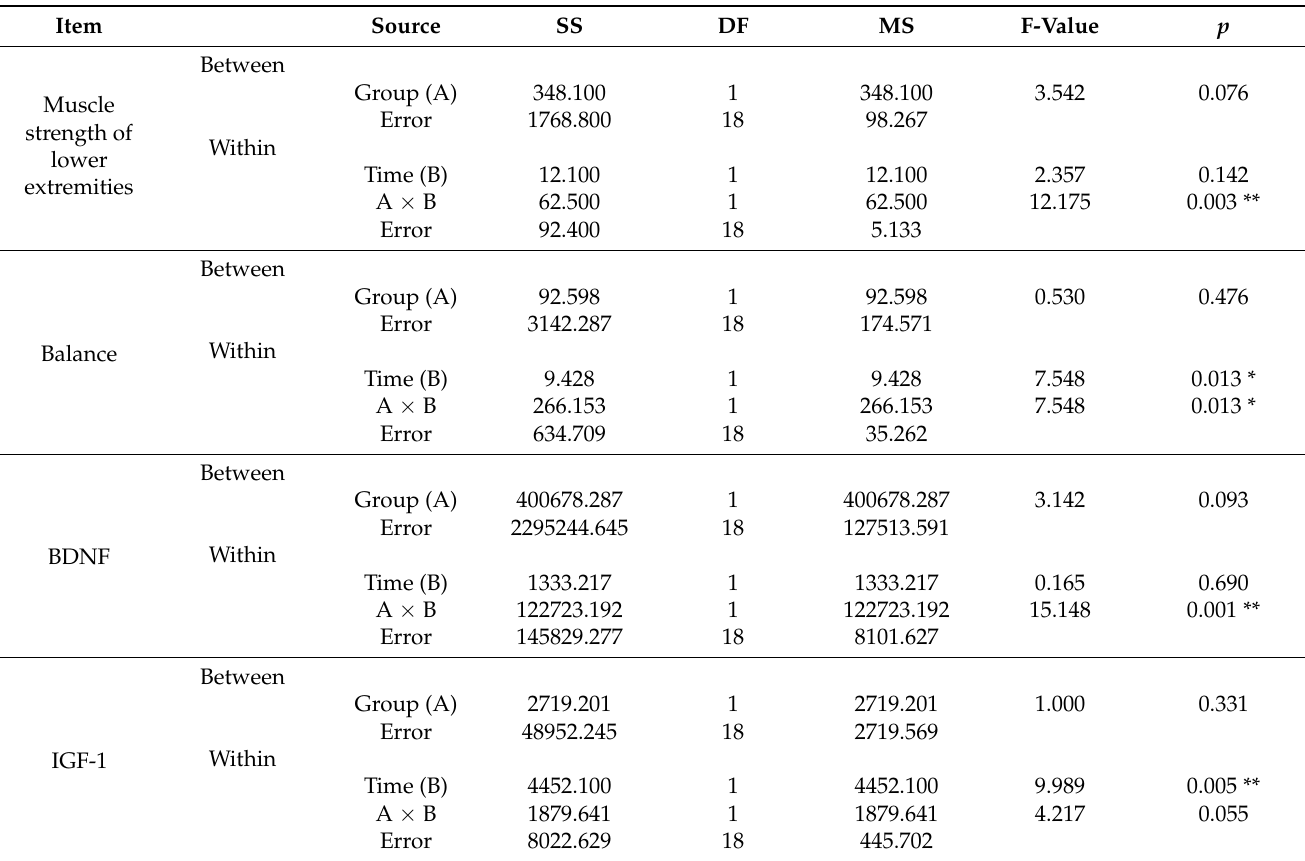
Table 3. Results of two-way ANOVA.